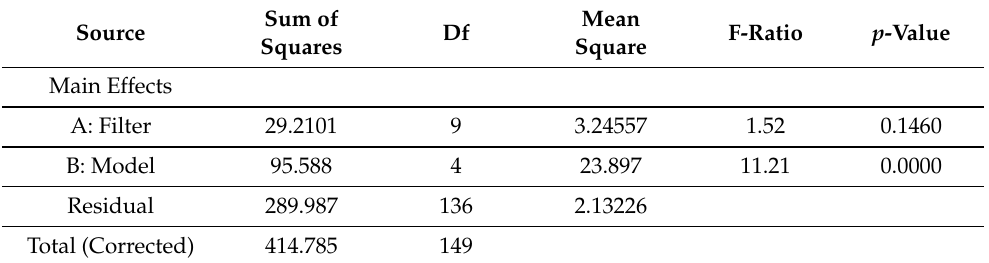
Table 6. Analysis of Variance for the dependent variable that analyzes the AUC of the system when the model and the filter are